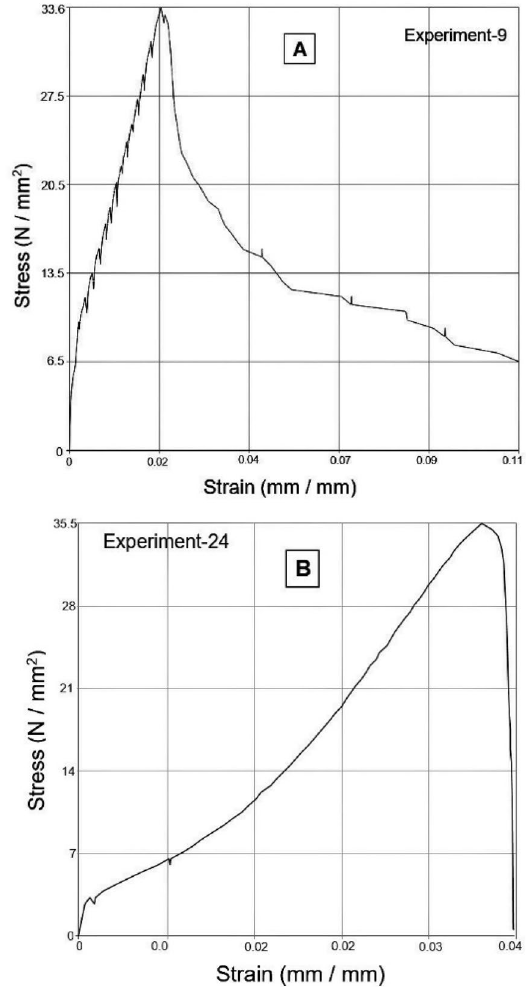
Figure 7 a Stress-strain diagram of Experiment 9, b stress-strain diagram of Experiment